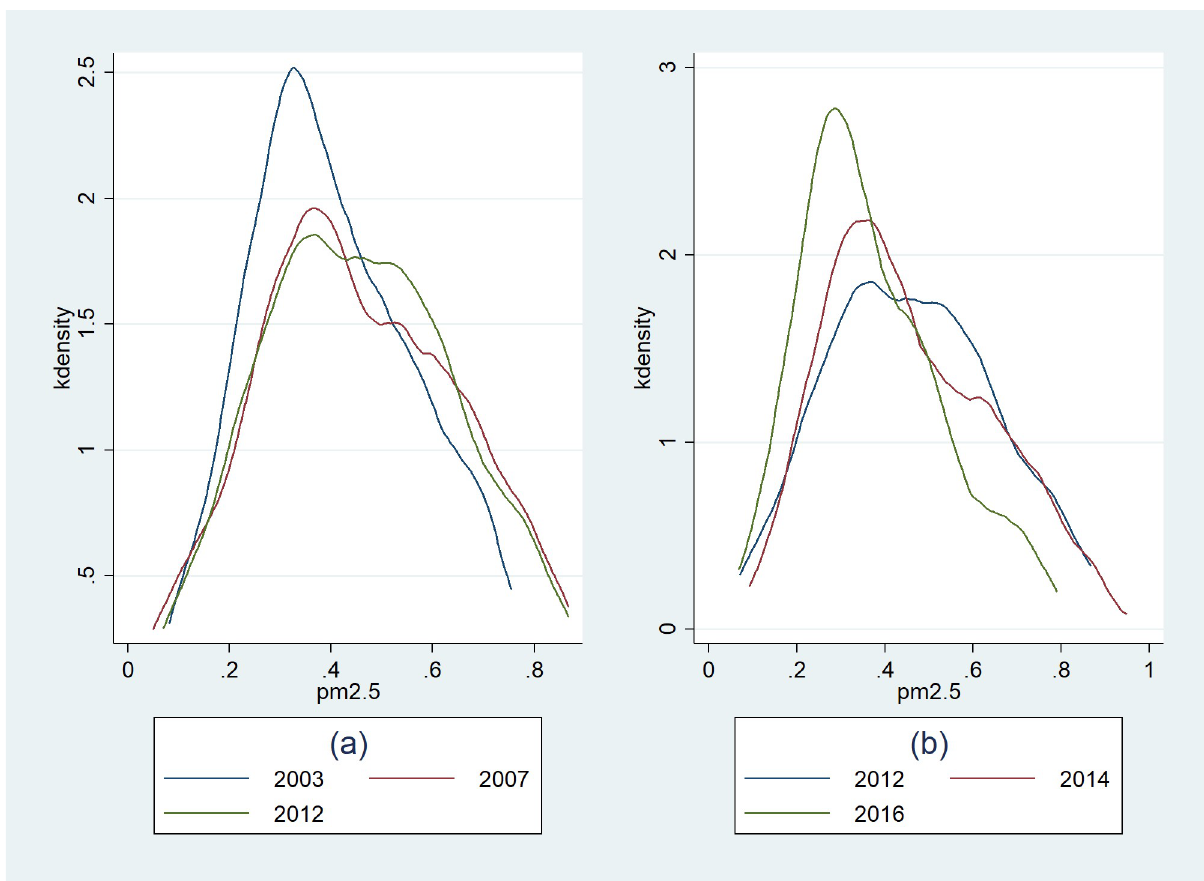
Fig 1. Kernel Density Estimation of PM 2.5 concentration: ( a ) Description of PM 2.5 before 2012; ( b ) Description of PM 2.5 after 2012.